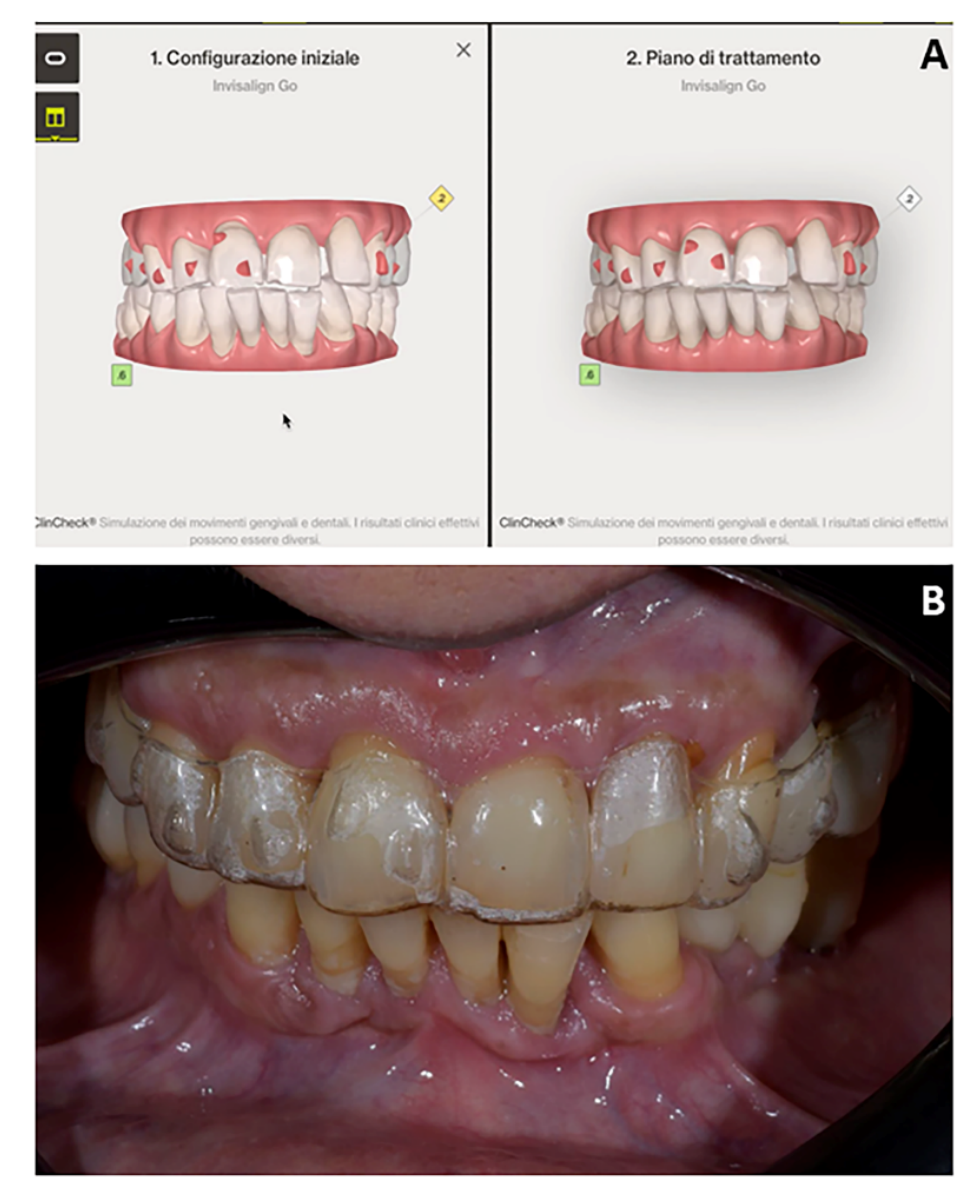
Figure 18. Case 3. ( A ) Orthodontic set-up (Invisalign Go platform); ( B ) intra-oral photograph with clear aligner.